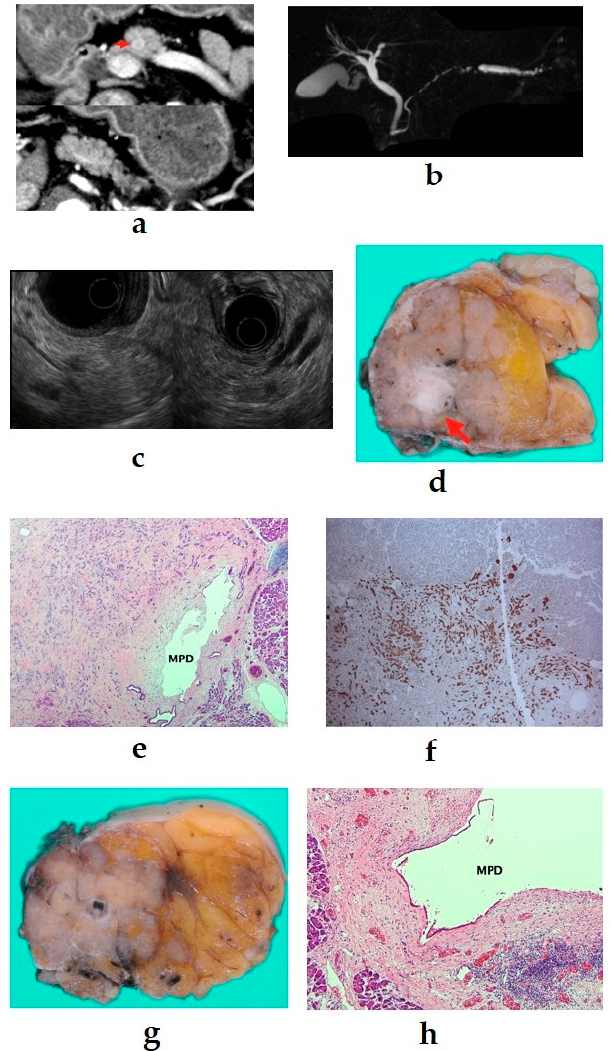
Figure 4. ( a ) Contrast-enhanced computed tomography (CT): a mass lesion with early hyperenhancement is seen in the pancreatic body (red arrow), but there are no other obvious lesions. ( b ) Magnetic resonance imaging: the main pancreatic duct (MPD) in the pancreatic body is extensively narrowed, and the caudal duct is dilated. ( c ) Endoscopic ultrasound (EUS): a circular hypoechoic mass in the pancreatic body. Pancreatic duct stenosis is observed even in the absence of mass. ( d – f ) 6-mm neuroendocrine neoplasm G1 (red arrow), serotonin positive, with stromal fibrosis (40 × ). ( g , h ) Pancreatic duct stenosis due to stromal fibrosis upstream of the tumor (40 ×